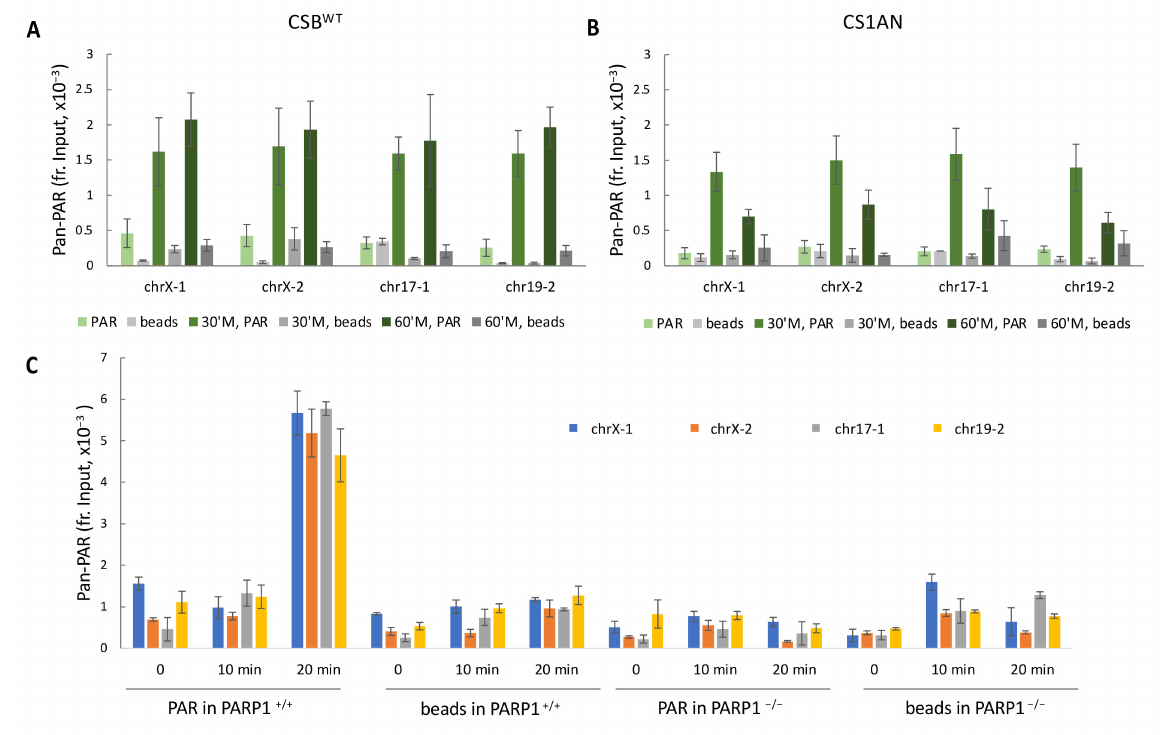
Figure 3. CSB regulates PAR levels at the top four CSB-binding sites induced by oxidative stress. ( A – C ) PAR levels at the four CSB binding sites during menadione treatment. A pan-PAR binding reagent was used to isolate PAR-enriched chromatin from formaldehyde crosslinked cells at the specified time points. The recovered chromatin was reverse-crosslinked and subjected to qPCR. ( A ) CSB WT cells. ( B ) CS1AN cells. ( C ) Validation of the pan-PAR binding reagent using PARP1 − / − and PARP1 +/+ RPE cells. PAR enrichment at these four regions was only significantly detected in PARP1 +/+ cells after 20 min of menadione treatment. (UT =